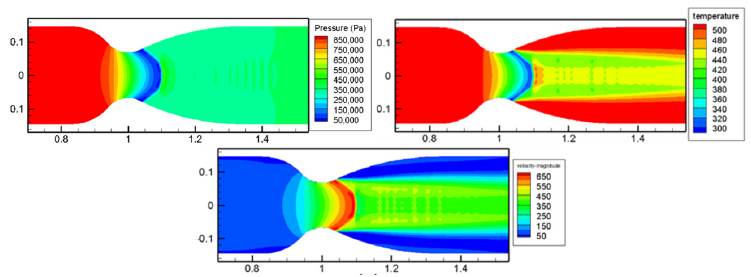
Figure 4. Converged results: ( a ) static pressure [Pa]; ( b ) temperature [K]; and, ( c ) velocity magnitude [m/s].